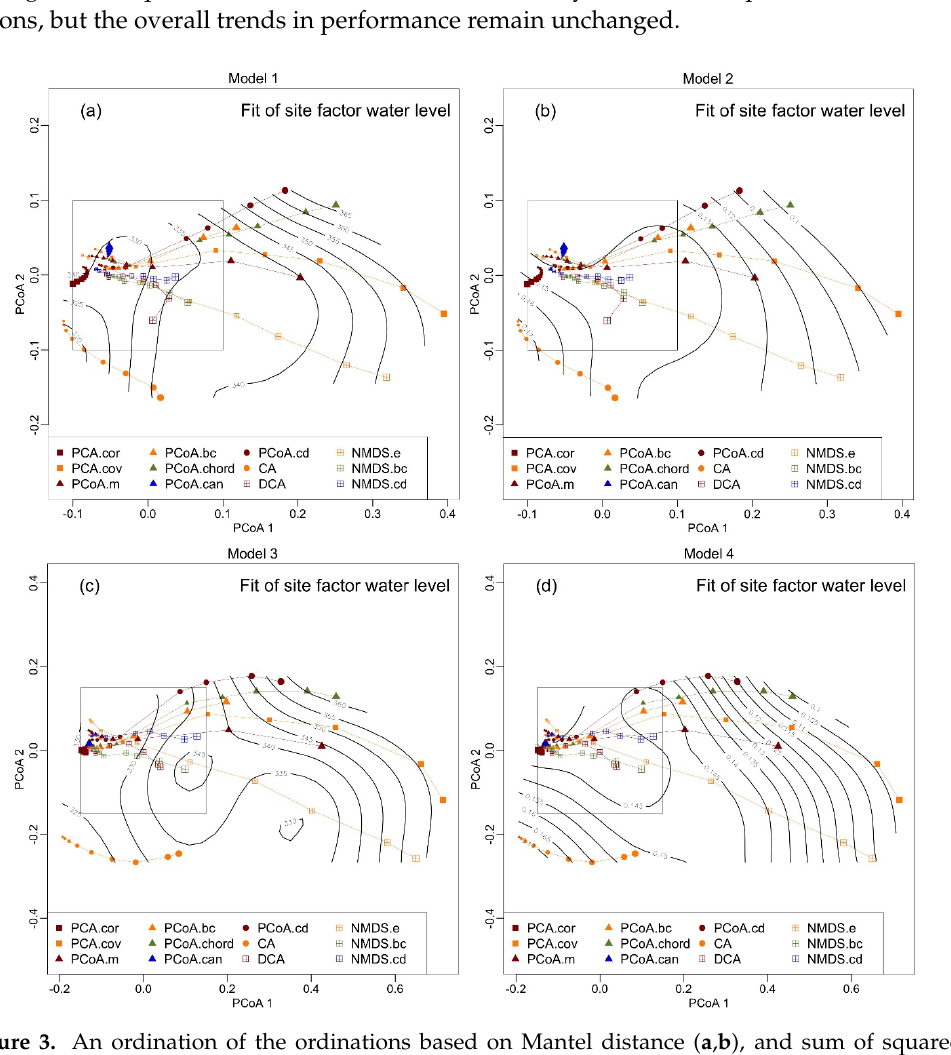
Figure 3. An ordination of the ordinations based on Mantel distance ( a , b ), and sum of squared differences obtained in procrustean analysis ( c , d ). Symbol size corresponds with the transformations shown in Figure 1. Light lines connect identical methods. Isoclines show the fit of site factor “Waterlev.av” (a variable in data-frame “ssit” measuring water supply) to the individual ordinations derived from vegetation data-frame “sveg”. In panels ( a , c ) the fit of trend surfaces adjusted to the individual ordinations is used; in panels ( b , d ) it is variance explained by NP-MANOVA.